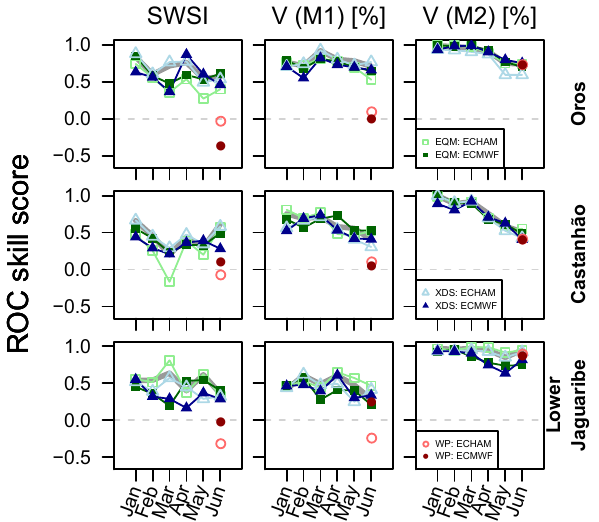
Figure 12. ROCSS of the forecast of drought events as defined by SWSI, V predicted with M1 and V predicted with M2 (based on month-to-month variation). An event is defined when an index is lower than the 30th percentile of the observations. The fore- cast period is January to June. Three regions are presented: lower Jaguaribe, Orós and